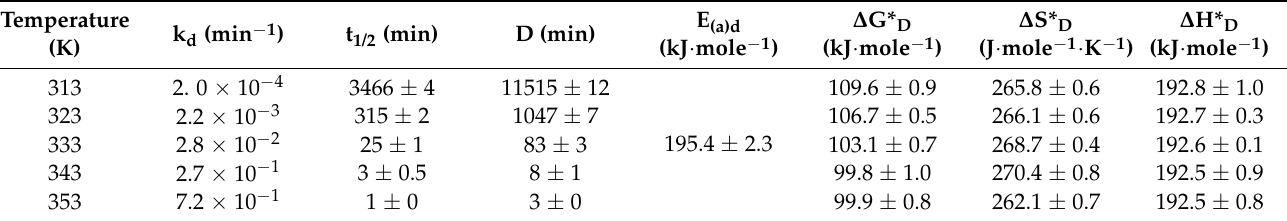
Table 5. The thermodynamic parameters for the thermal inactivation of BsXyn10.